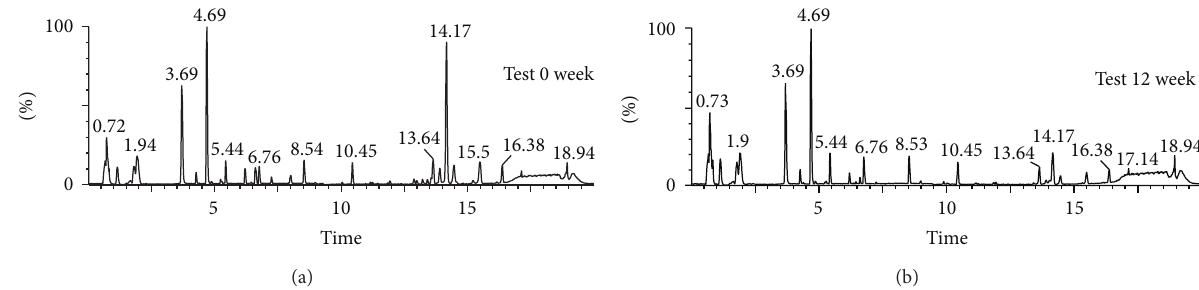
Figure 1: Ultraperformance liquid chromatography-quadrupole-time-of-flight mass spectrometry (UPLC-Q-TOF MS) profiles of sera from human subjects who were controlled by BSPs before and after 12 weeks of